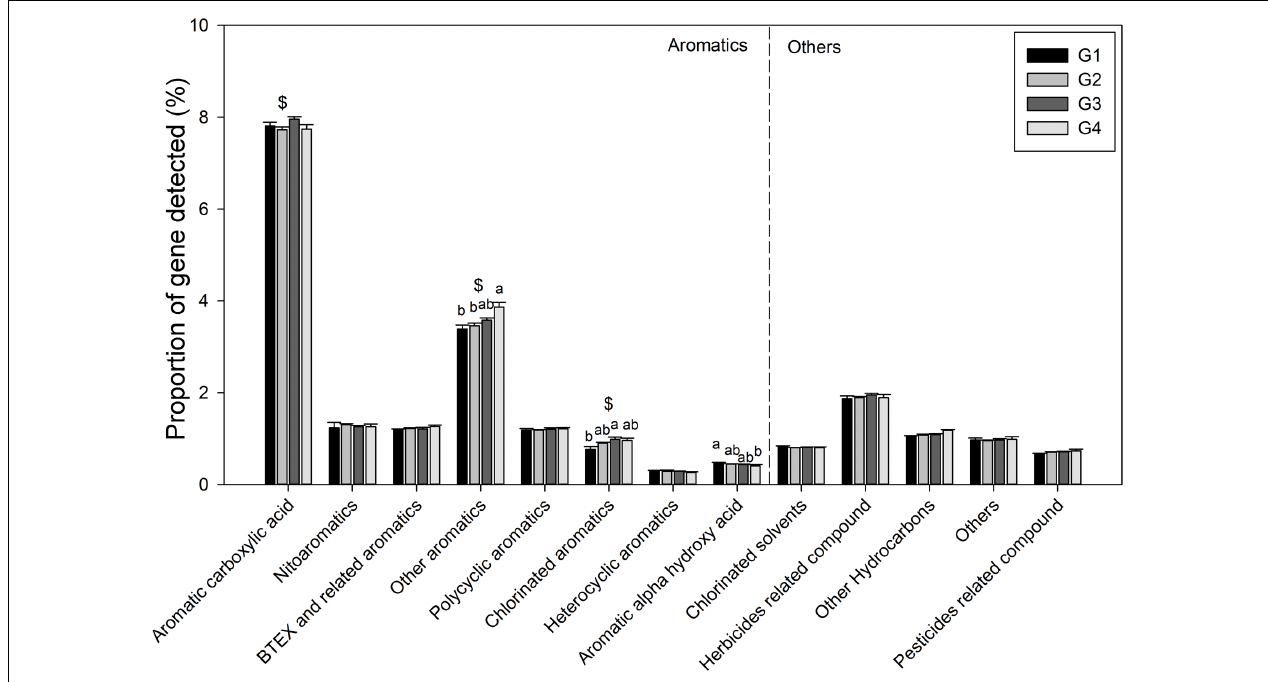
FIGURE 4 | Proportions of each subcategory within organic remediation. All data are shown as mean ± standard deviation. Significant differences between the groups, and between surface and bottom samples, indicated by ANOVA with Tukey’s post hoc test are indicated by letters a and b, and by ∗ and $, separately, above the bars. The different letters indicate P < 0.05. ∗ Indicates higher mean proportion in surface samples, while $ indicates higher mean proportion in bottom samples with P <